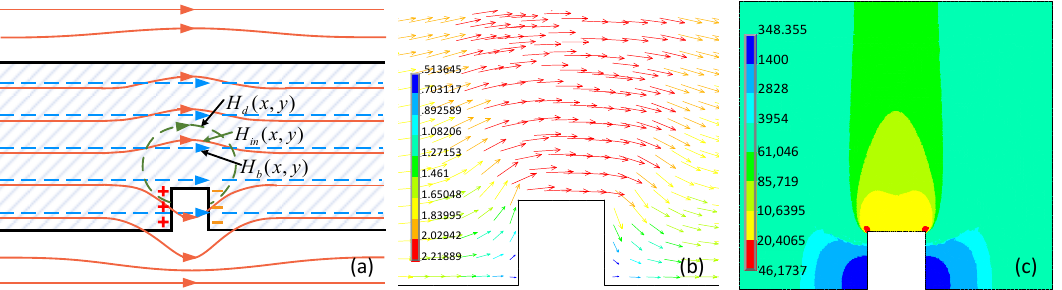
Figure 4. Dynamic magnetic action inside the material obtained by using the finite element method. The rectangular defect has the size of 1.2 mm (length) and1.5 mm (height). ( a – c ) shows the magnetic field lines, the magnetic vector, and the magnetic contour, respectively.